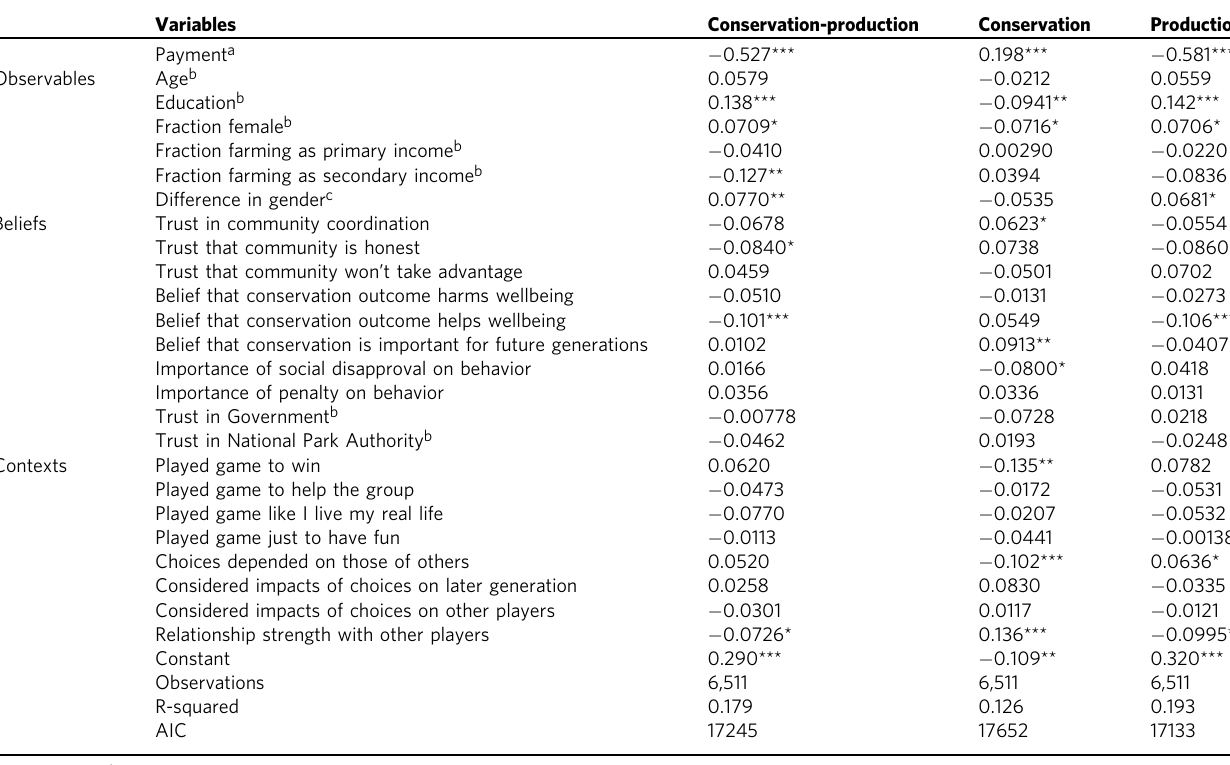
Table 3 Conservation, production, and joint conservation-production outcomes by observables, beliefs, and contexts for 5-game